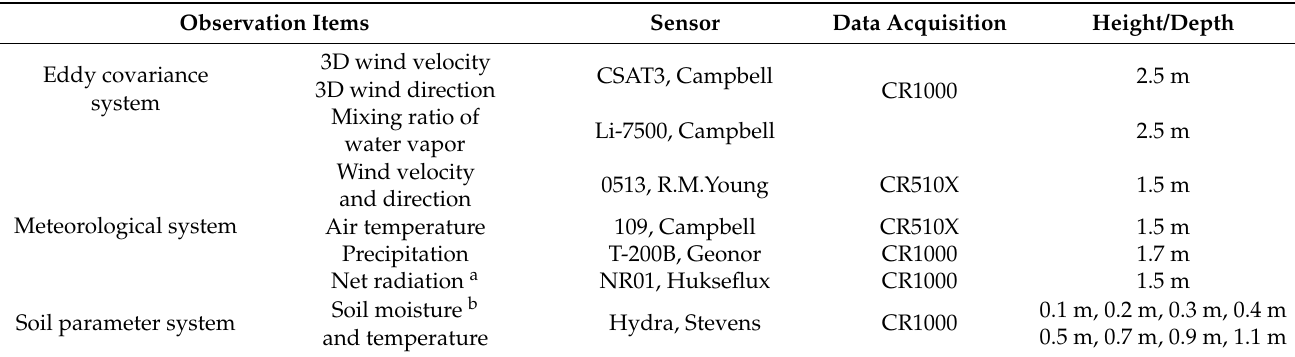
Table 1. List of the observation items and instruments at the TGL